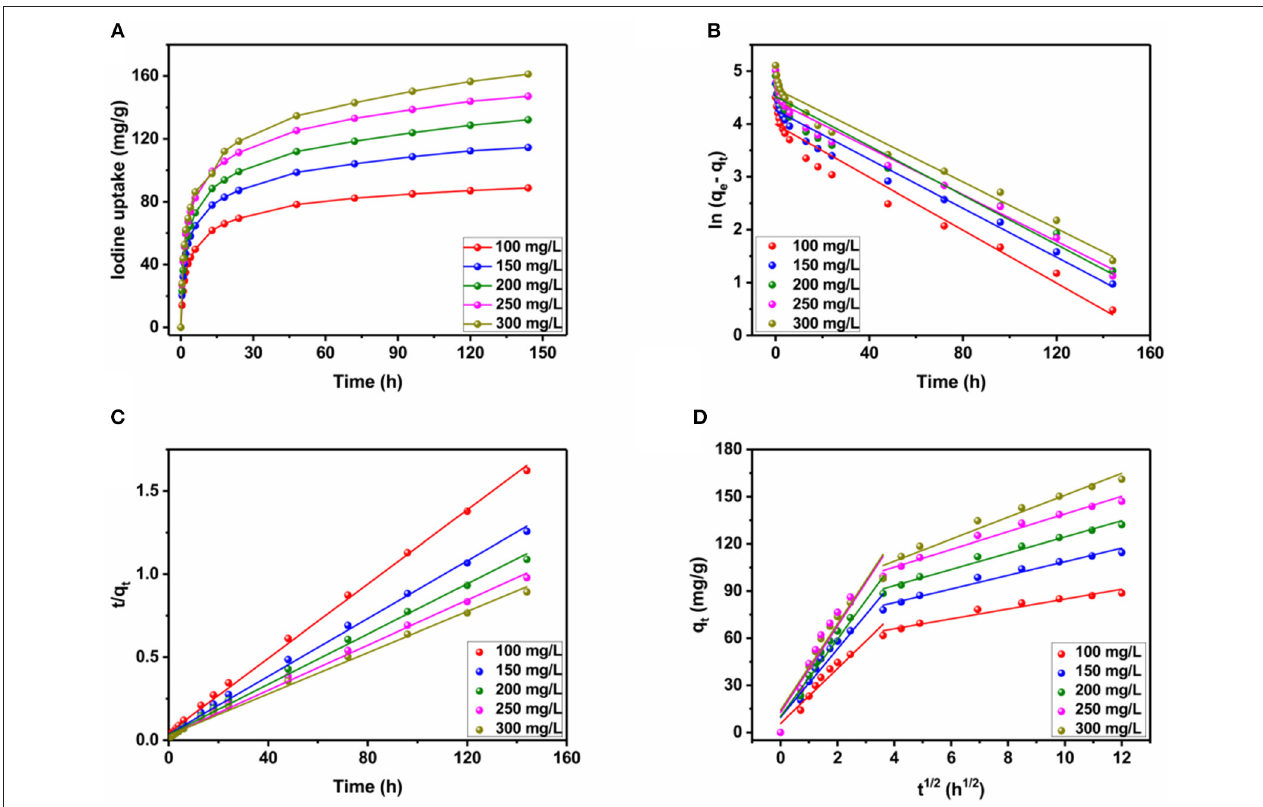
FIGURE 4 | (A) Kinetics of iodine adsorption over JLUE-COP-3 at different concentrations (100–300 mg/L) at T = 298K. (B) Pseudo-first-order curve-fittings. (C) Pseudo-second-order curve-fittings. (D) Intraparticle diffusion models for iodine adsorption over JLUE-COP-3 at different initial iodine concentrations.